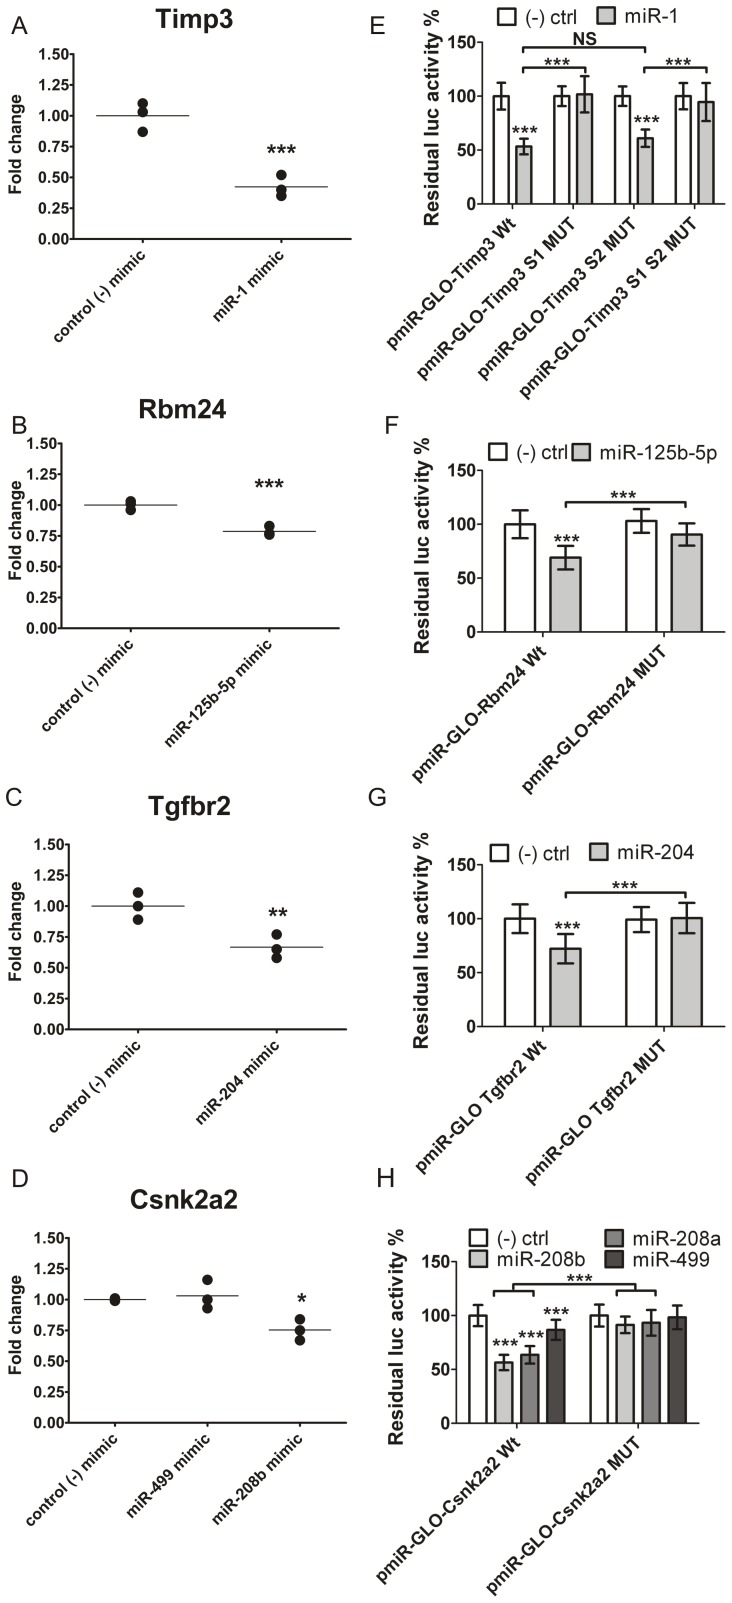
Anti-correlated microRNA targets are directly inhibited by microRNA over expression.(A–D) Real-Time RT-PCR of Timp3, Rbm24, Tgfbr2 and Csnk2a2 in HPASM cells transfected with mimics for miR-1, miR-125b-5p, miR-204, miR-499 and miR-208b or with a mimic microRNA negative control. Data were normalized to 18S RNA. (E-H) Luciferase activity of wild-type (WT) or mutant (MUT) Timp3, Rbm24, Tgfbr2 and Csnk2a2 3′-UTR reporter genes cotransfected with their paired microRNA mimics. Data were averaged for n = 4 in 3 independent experiments and error bars represented standard deviation of the mean. P values: * = P<0.05, ** = P<0.01, *** = P<0.005.